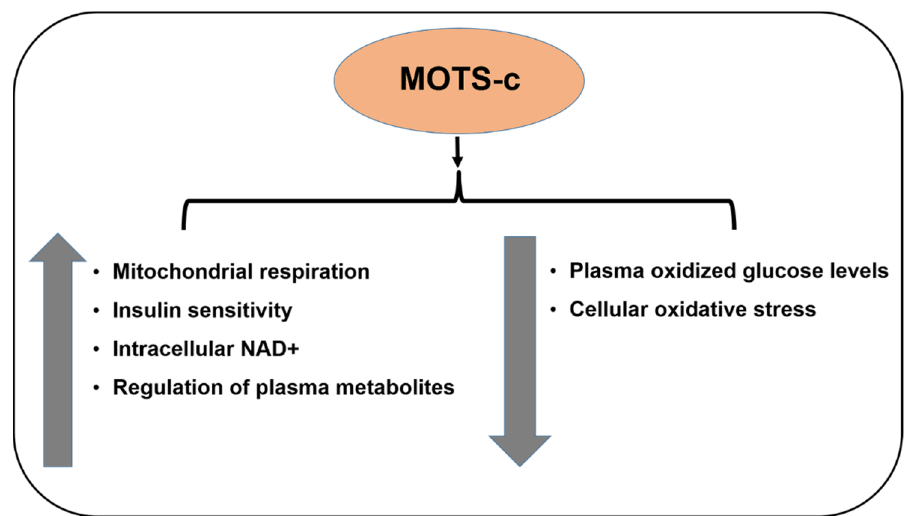
Figure 5. Effects of MOTS-c.